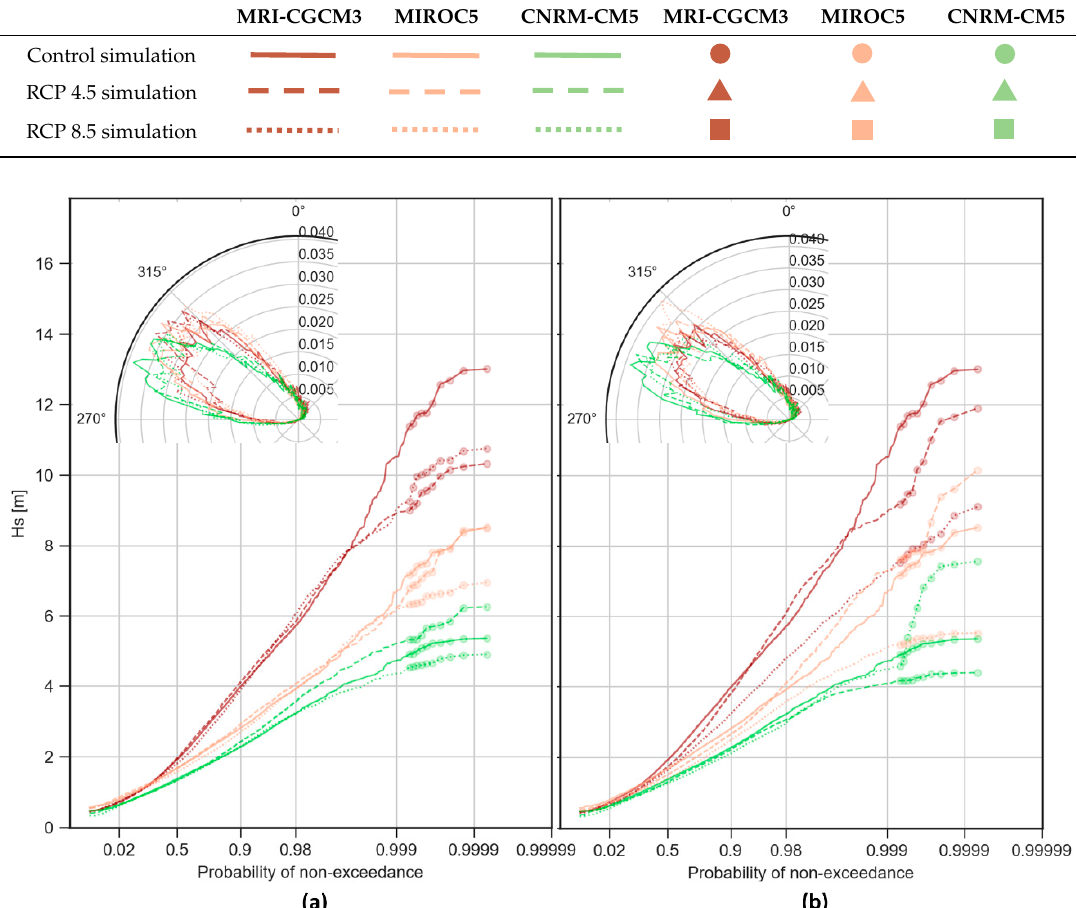
Figure A1. CDFs of the propagated values of H S at deep waters (spring dataset) with a detail of the polar PDFs of wave directions for: ( a ) Control simulations and short-term simulations (2026–2045) of all models and concentration scenarios; ( b ) Control simulations and long-term simulations (2081–2100) of all models and concentration scenarios.